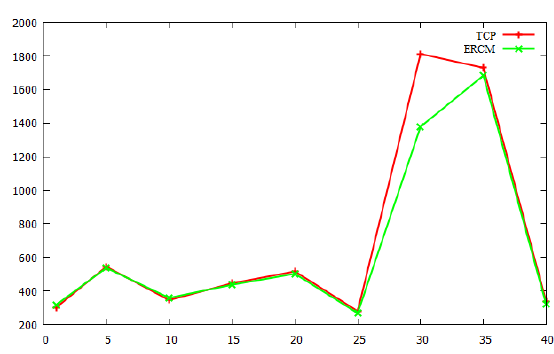
Fig. 6. Congestion loss vs. Mobility for 65